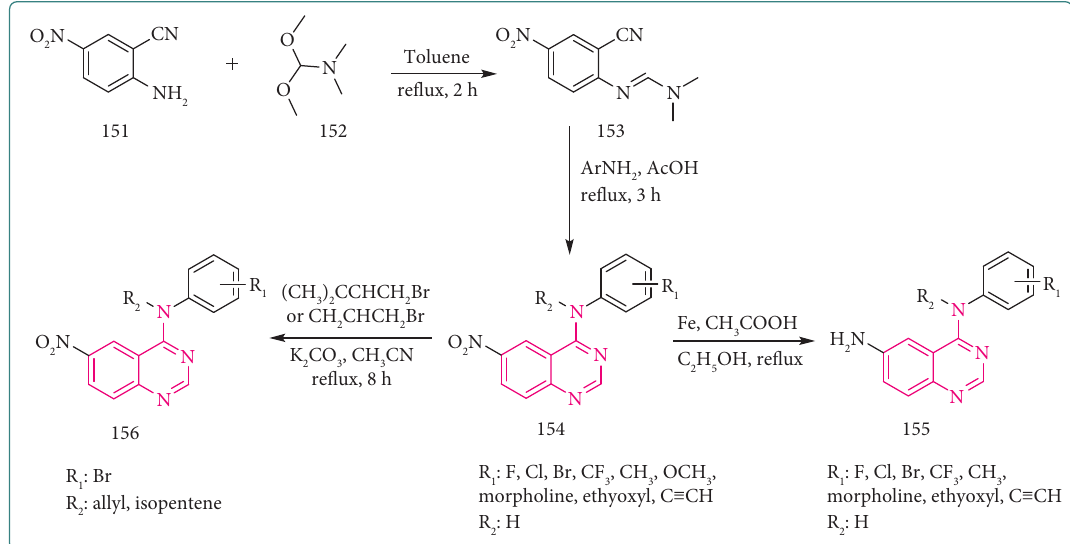
Scheme 28: Synthesis of a new series of 4-aminoquinazolinone derivatives using 2-cyano-4-nitro-aniline.